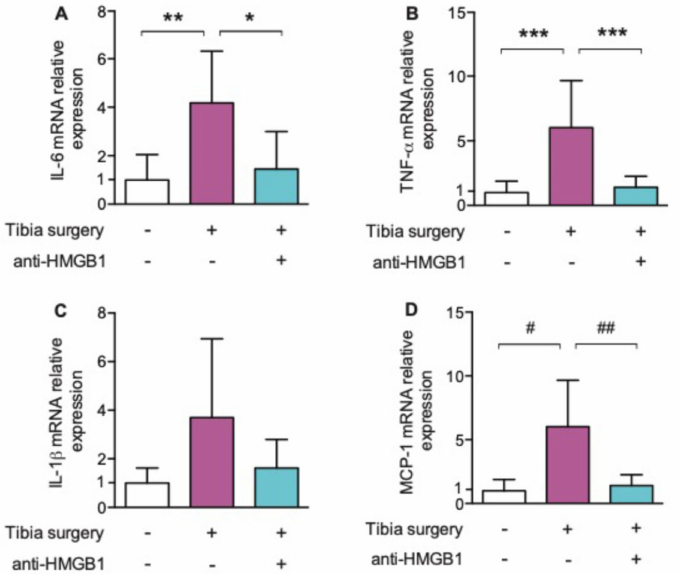
Figure 5. ( A – D ): Effects of anti-HMGB1 antibody on hippocampal interleukin (IL)-6, tumor necrosis factor (TNF)- α , IL-1 β and monocyte chemotactic protein (MCP)-1 24 h postoperatively. Postoperative hippocampal Il-6; TNF- α , IL-1 β and MCP-1 levels significantly decreased after anti-HMGB1 antibody ( n = 6; * p = 0.023; ** p = 0.009; *** p < 0.001; # p = 0.003; ## p = 0.005 with one-way ANOVA